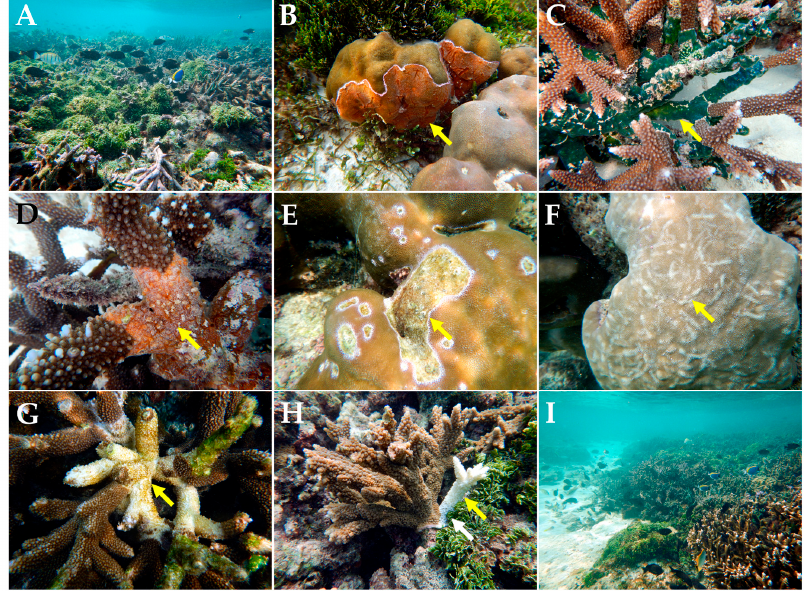
Figure 3. Cheriyam: ( A ) C. racemosa overgrowth in a coral reef habitat; ( B ) Overgrowth of unknown coral competing sponge on P. solida ; ( C ) Overgrowth of colonial ascidian species on A. muricata ; ( D ) Coral competing for sponge over Acropora sp.; ( E ) Tissue loss in P. solida ; ( F ) Predation/fish bites in Porites sp.; ( G ) Acropora white syndrome depicting multi-focal tissue loss; ( H ) Acropora depicting tissue loss (yellow arrow) in areas in contact with H. opuntia (white arrow); ( I ) Macroalgae overgrowing reefs [Photographs by R.R. Das, C.R. Sreeraj, and G. Mohan].